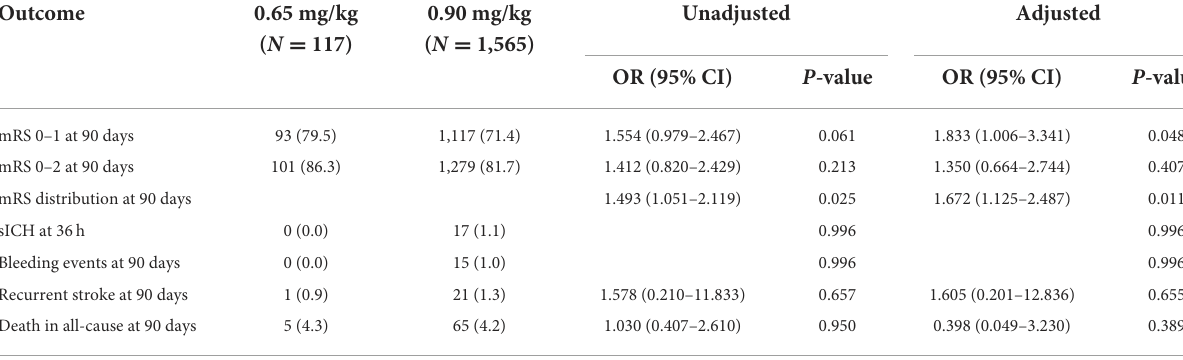
TABLE 3 Effectiveness and safety outcomes between 0.65 and 0.90 mg/kg r-tPA groups.